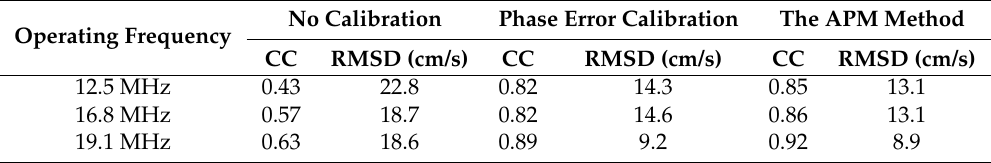
Table 5. Radial current measurements with the Zhujiajian MHF radar using three calibration strategies. Only four-element datasets are involved in the MHF radar radial current